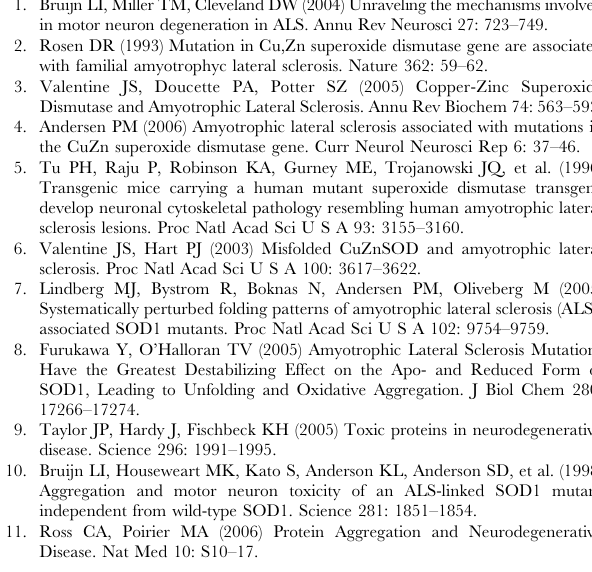
Table S2 Extraction from E. coli cells and metal reconstitution with zinc. The metal contents of the proteins are shown as equivalents of each metal per enzyme